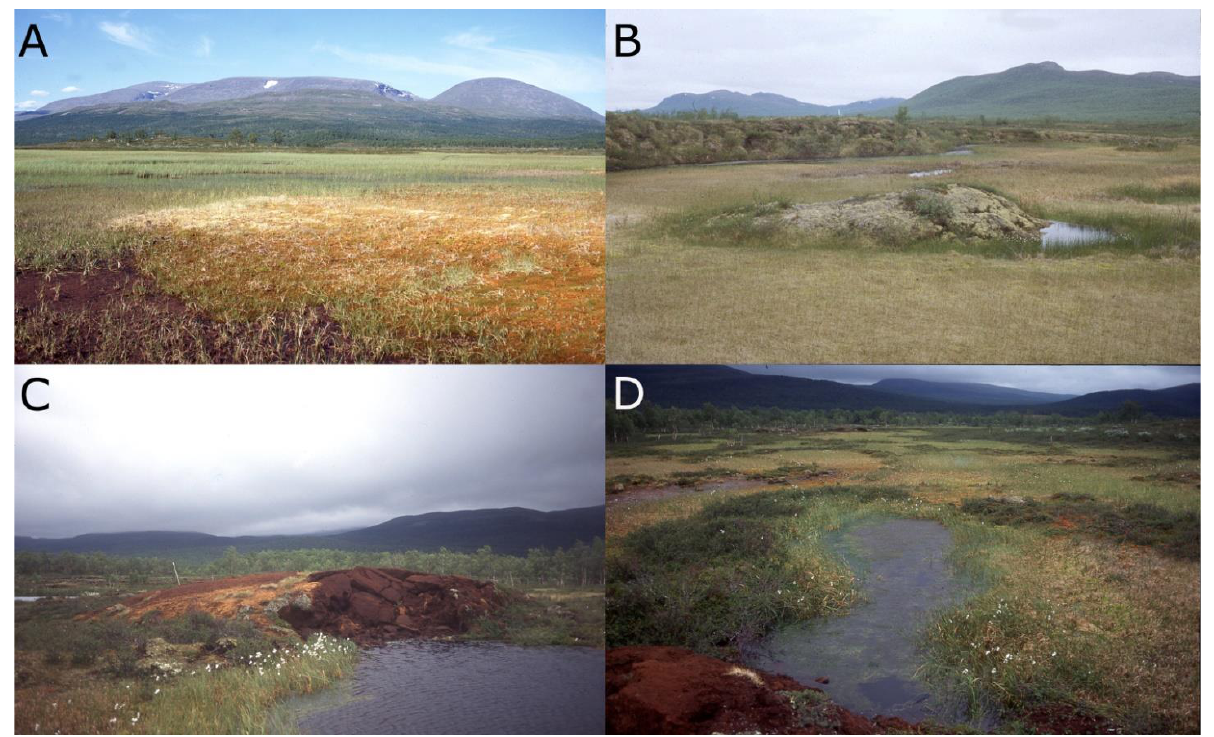
Figure 1. Palsa stages, Sweden: (A) Embryo, August 1996, Laivadalen; (B) Young (foreground) and mature (background) palsa, July 1996, Keinovuopio, Kätkijärvet; (C) Degrading palsa, August 1996, Laivadalen; (D) New peat formation in palsa pond with a remnant palsa in the foreground, August 1996,